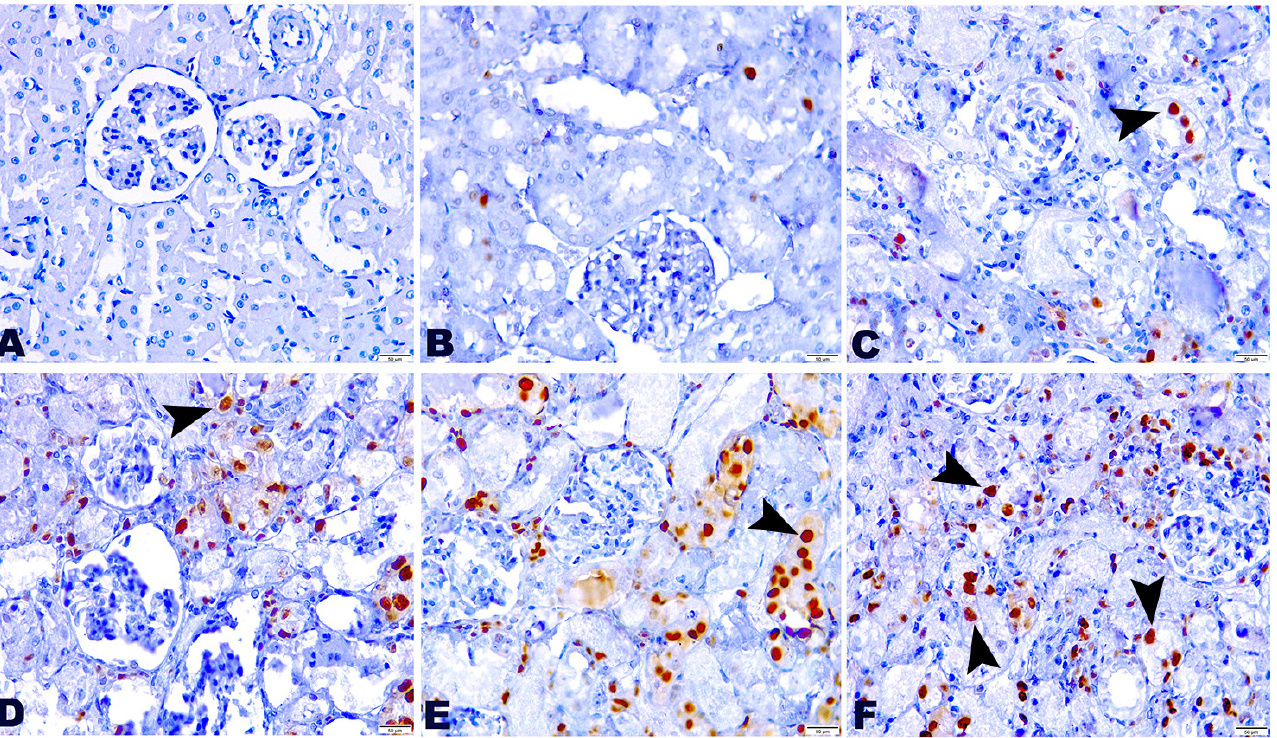
Figure 5. The effect of TG and GM combined treatment on the PCNA expression in renal tissue. ( A ) The control group exhibited negative PCNA expression. ( B , C ) The TG7 and TG14-treated groups pronounced few nuclear PCNA reactions. ( D ) The GM group bared moderate reactivity to PCNA. ( E , F ) The TG7+GM and TG14+GM groups highlighted intense positive nuclear PCNA expression in a dose-dependent manner. The positive staining of PCNA is pointed out by the arrows and indicated by a brown stained renal nuclei (PCNA, 400× magnification).